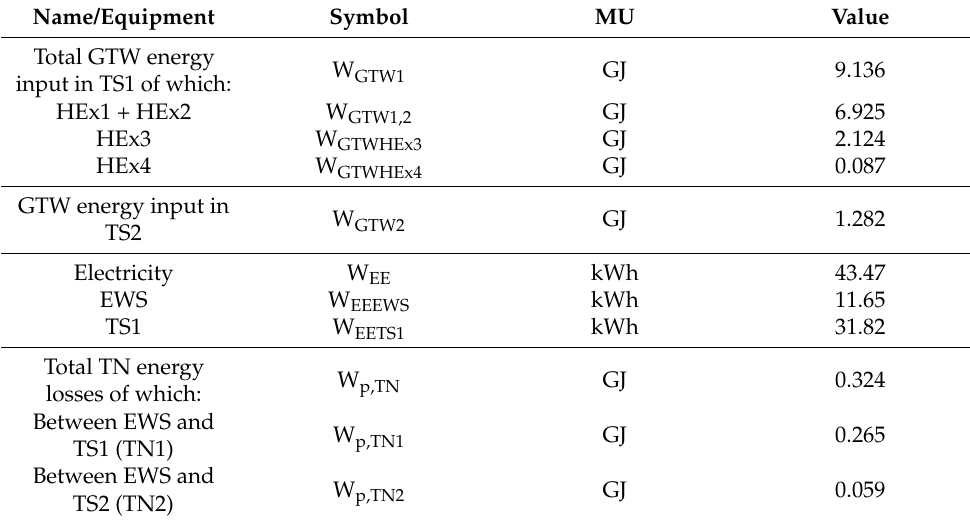
Table 9. Average hourly values of W I 20–22 January